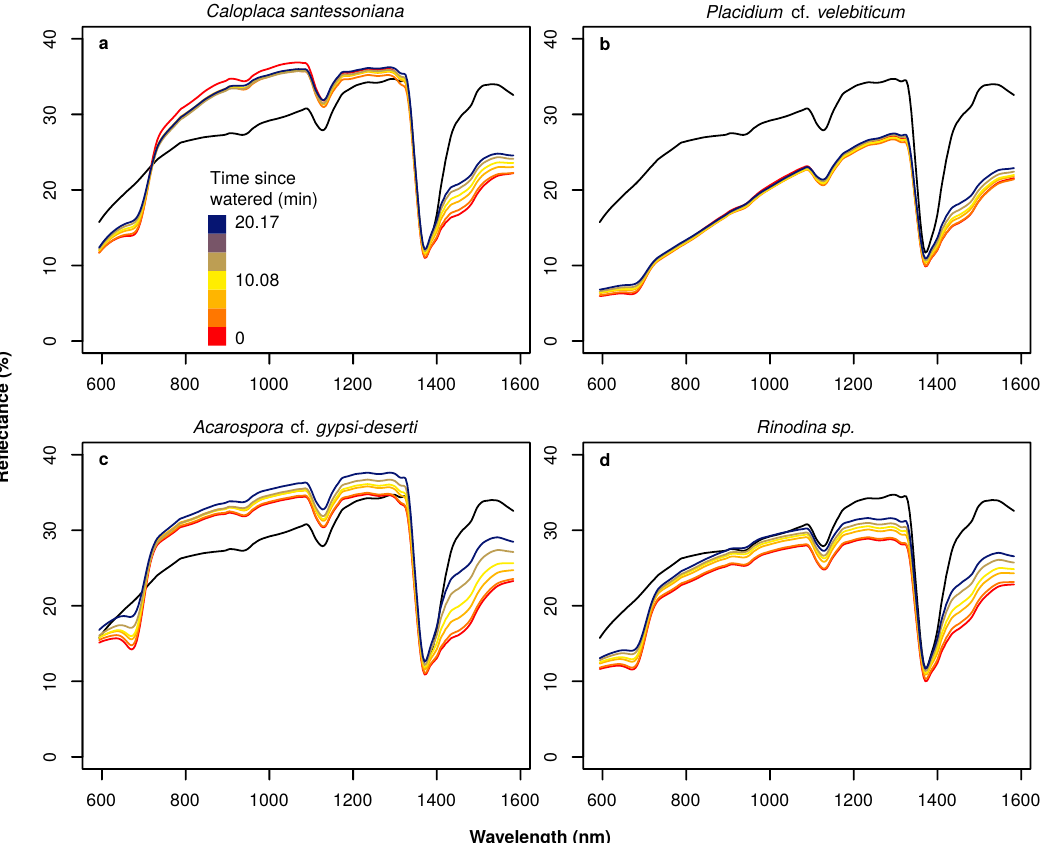
Figure 4. Hyperspectral reflectance of soil (black) and biological soil crust species Caloplaca santessoniana ( a ), Placidium cf. velebiticum ( b ), Acarospora cf. gypsi-deserti ( c ) and Rinodina sp. ( d ) in the dry condition (red) and after being artificially watered in the field (orange to blue colors), measured with the hyperspectral